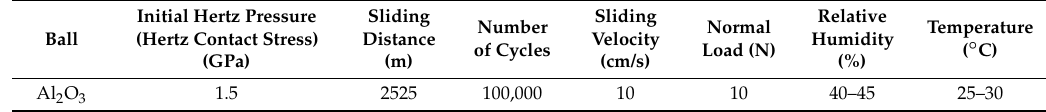
Figure 2. Ball-on-disc configuration friction test ( a , b ) and view of test apparatus ( c ). Table 2. Parameters used in friction tests.